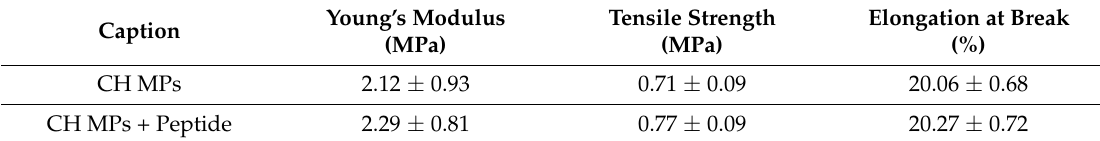
Table 2. Mechanical properties of CH films incorporated with peptide-loaded CH